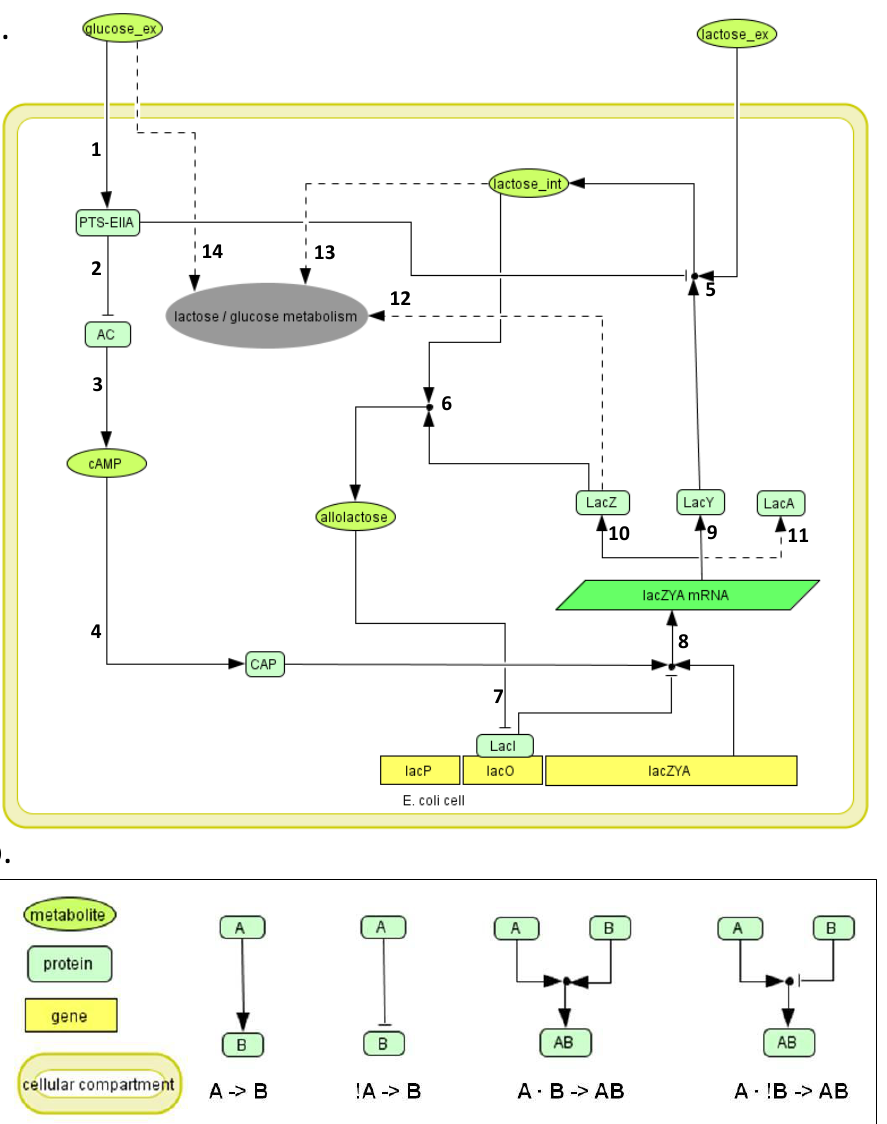
Figure 1: (a) Boolean model of the lac operon, hyperarcs are numbered according to the annotations in table 2. (b) Legend of graphical representations of logic